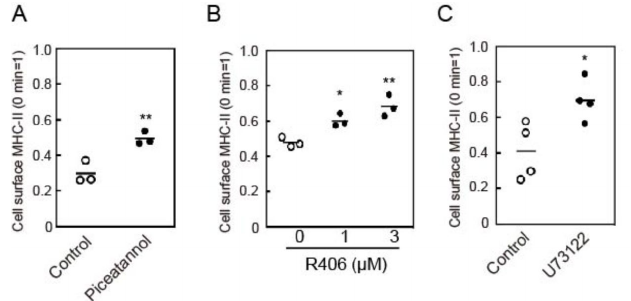
Figure 3. Effects of Syk and phospholipase C (PLC) inhibitors on crosslinking-induced MHC-II endocytosis. BMDCs were pre-incubated with ( A ) piceatannol (50 µM), ( B ) R406 (indicated concentrations), or ( C ) U73122 (10 µM) for 30 min at 37 °C. The cell surface MHC-II was crosslinked with an anti-MHC-II antibody for 30 min. The remaining cell surface MHC-II was detected by flow cytometry. Values of * p < 0.05, ** p < 0.01 are regarded as significant.